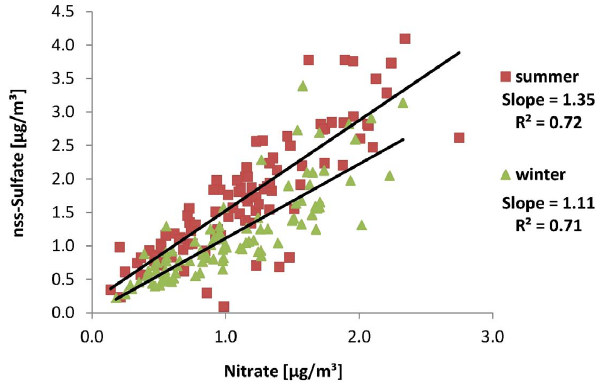
Figure 5. Correlation between nitrate and nss-sulfate between sum- mer and winter in samples collected from July 2010 to November